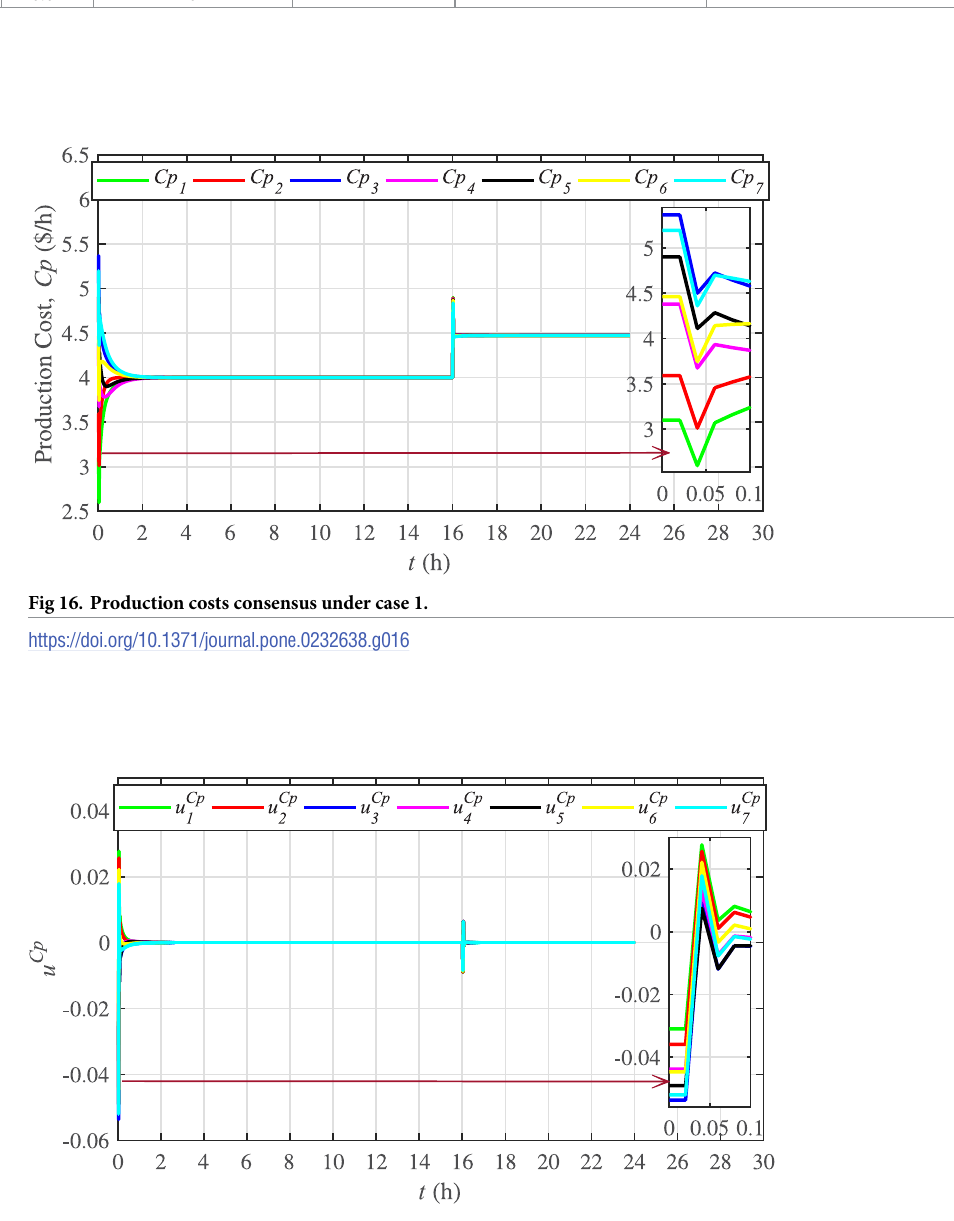
Fig 17. Production costs control efforts under case